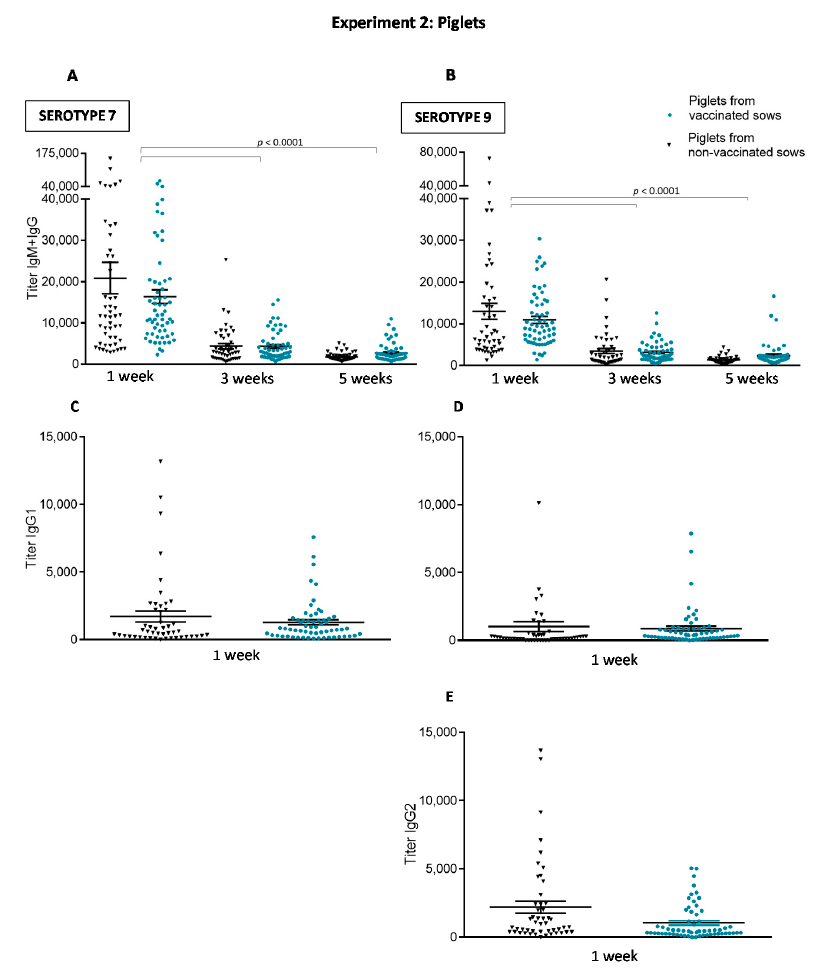
piglets derived from vaccinated vs. non-vaccinated sows (Figure 9; p = 0.76). As observed in Experiment 1 (Figure 4), OPA activity of antibodies was significantly lower at five weeks of age. At this age, levels were similar in both groups ( p = 0.041).